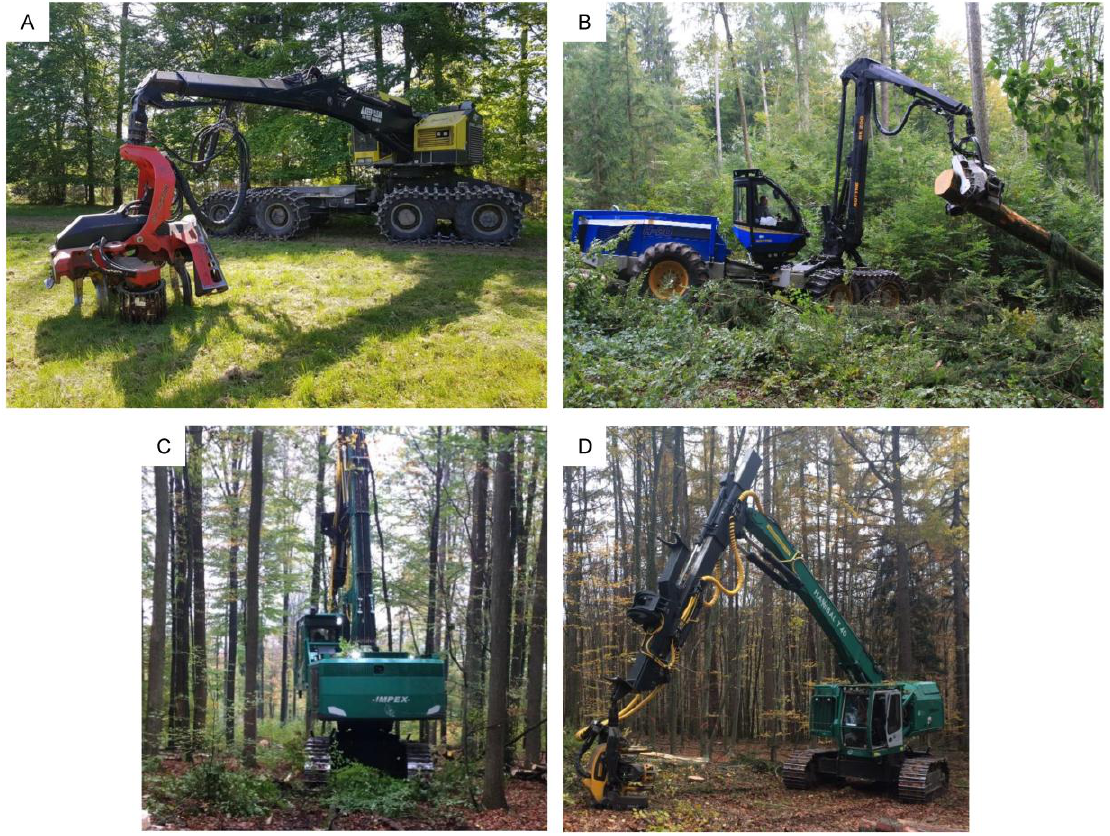
Figure 1. Harvesters used in the study: ( A ) TimberPro TF840-B, ( B ) Rottne H20, ( C ) Impex Hannibal T50, and ( D ) Impex Hannibal T40. Photo credit: ( A ) [16]; ( B – D ) [17].